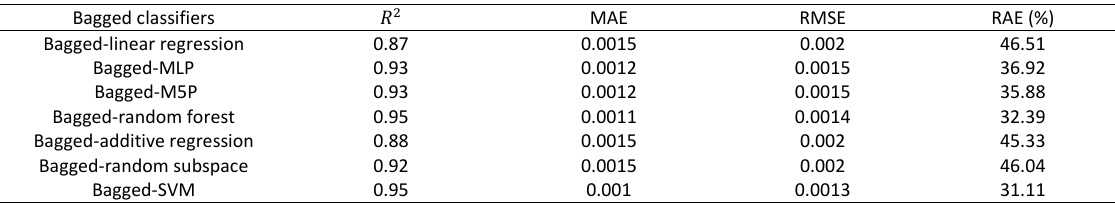
Table 3: Prediction performance of group-I classifiers in Bagging Bagged classifiers Bagged-linear regression